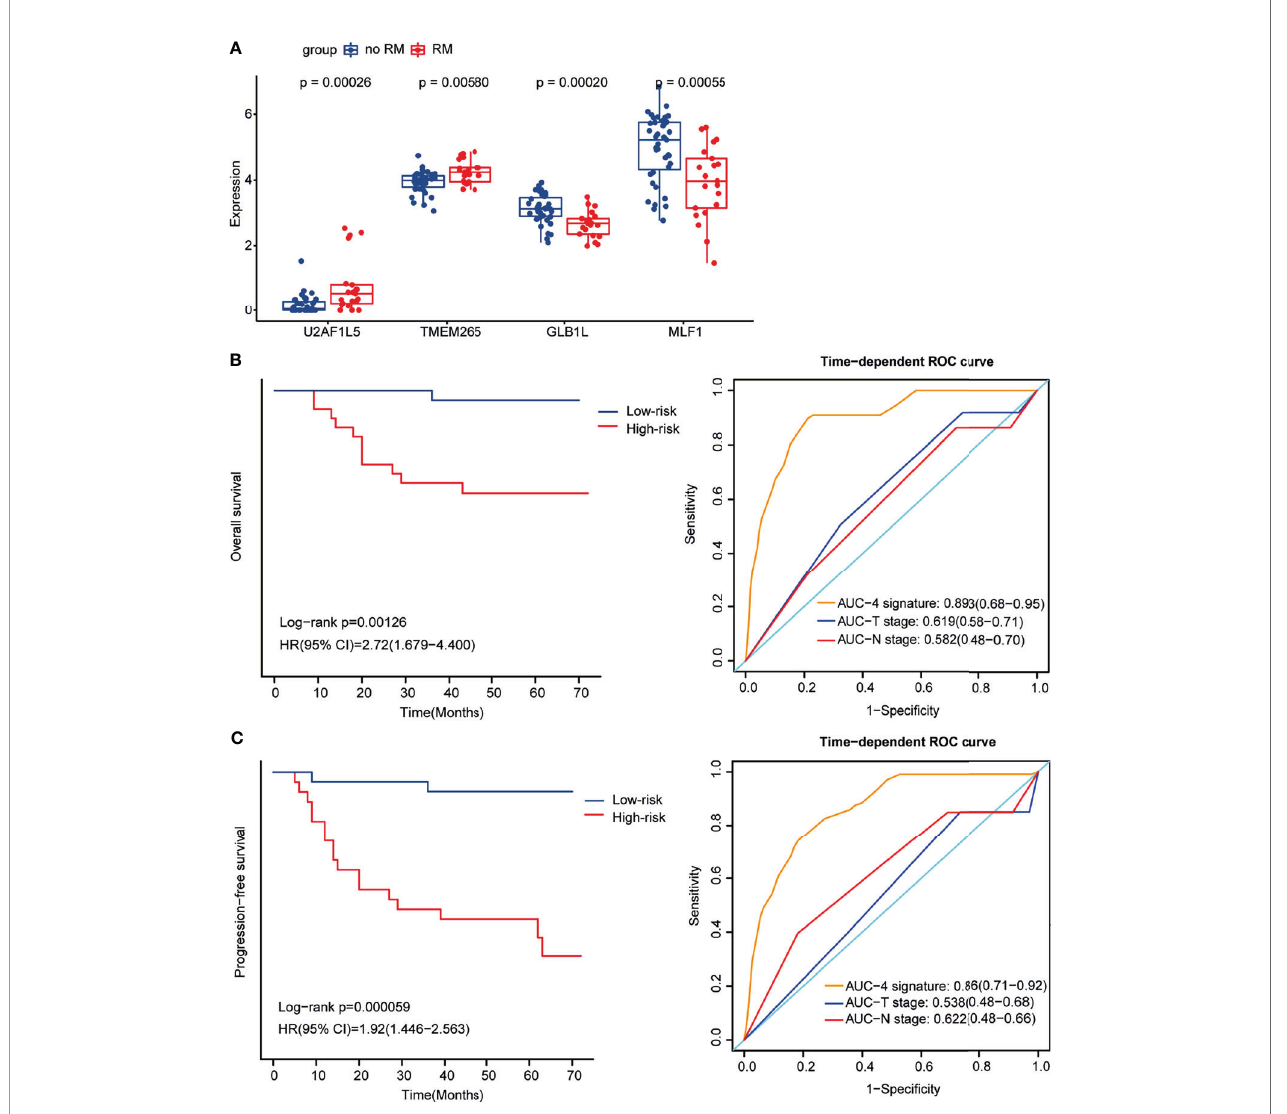
FIGURE 3 | Identi fi cation of 4 mRNAs by Multivariate Cox regression analysis and construction of the prognostic signature for NPC. (A) Box plot showing the expression level of the 4 mRNAs in the RM and no-RM groups. (B) Kaplan-Meier curves for OS for the high- and low-risk groups (left) and ROC curves for the 4- mRNA signature, T stage and N stage for OS (right). (C) Kaplan-Meier curves for PFS for the high- and low-risk groups (left) and ROC curves for the 4-mRNA signature, T stage and N stage for PFS